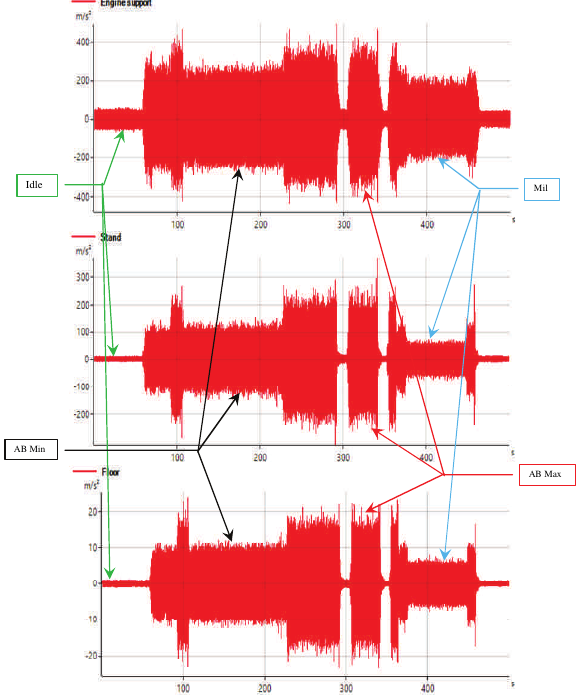
Fig. 4. Time histories of vibration signals for different measurement points Figure 5 shows the averaging amplitude spectrums of the vibration acceleration signals synchronously recorded in three different measurement points. The demonstrated spectrums are the results of the analysis of vibration signals being outcome of the different power settings. In this figure the results are grouped by terms of settings